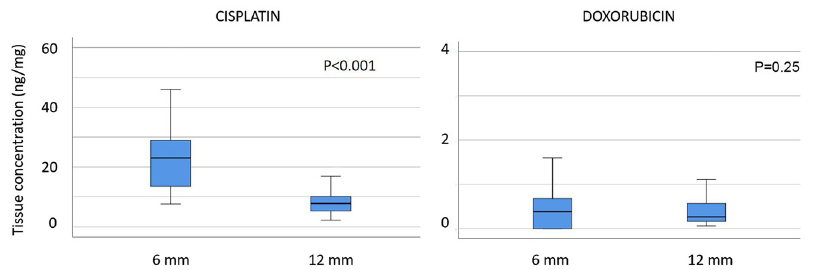
Figure 2: Influence of the probe geometry on tissue drug concentration. Tissue concentration of cisplatin (left panel) and doxorubicin (right panel), depending on the biopsy size. The biopsy geometry influences the measurement of cisplatin (p<0.001) but not doxorubicin (p=0.248). Thus, results of drug tissue concentration in peritoneal tissue depend on the biopsy geometry, but also the penetration of a speci fi c drug into the tissue.